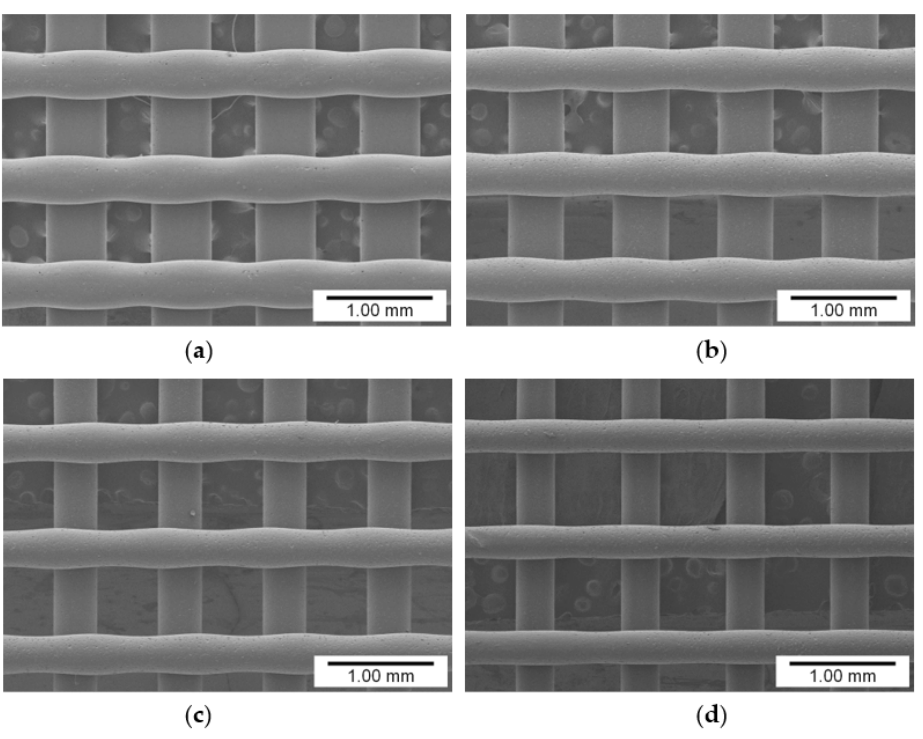
Figure 6. Lattice patterns of the membranes fabricated with different pigment concentrations: ( a ) 0, ( b ) 5, ( c ) 10, and ( d ) 15 wt.%.